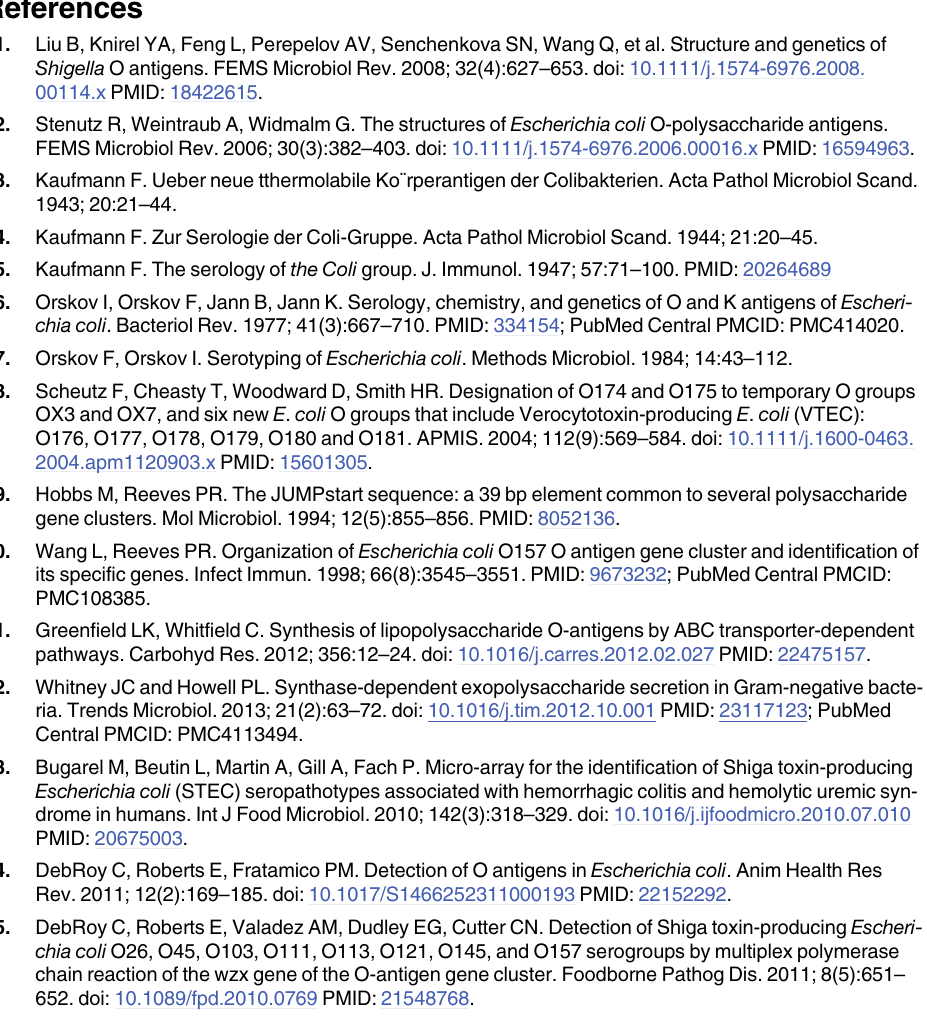
S1 Fig. Structure of O-AGC of all 196 O-serogroups. The O-AGCs of all 196 O- and OX- groups are diagrammatically represented. The nucleotide sequences of 71 O-groups marked with asterisk and in bold font were determined in the present investigation. S1 Table. Strains and GenBank accession numbers for O-AGCs of all known E . coli O-